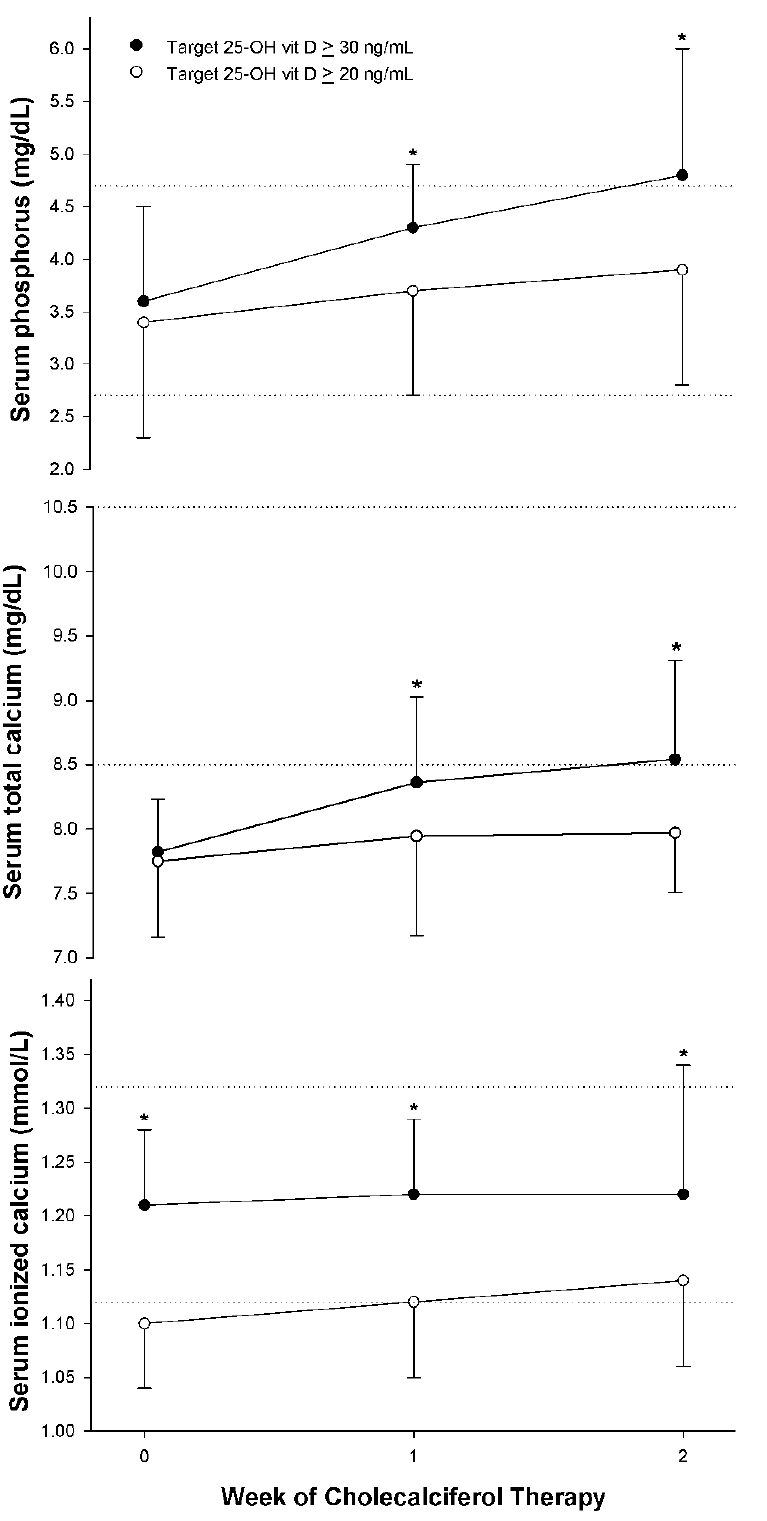
Figure 2. Serial serum ionized calcium, total calcium, and phosphorus concentrations during chole- calciferol therapy between the higher target (25-OH vit D ≥ 30 ng/mL) and lower target (25-OH vit D ≥ 20 ng/mL) groups, respectively. The dotted lines represent normal serum concentration range. Data given as mean + S.D.* p < 0.05 between target groups by week of